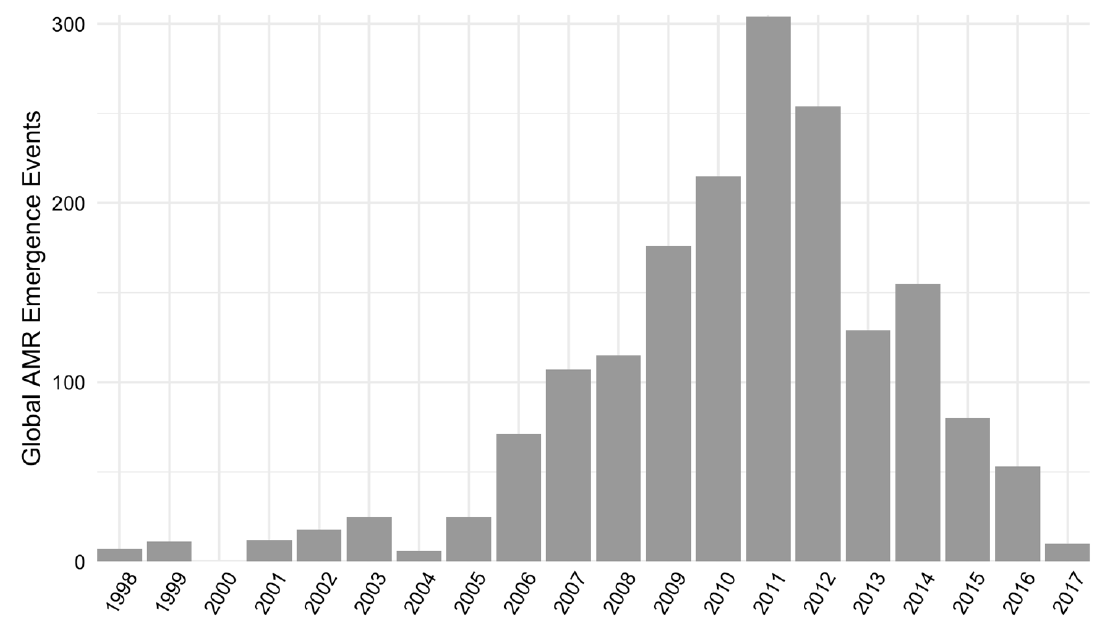
Figure 3. Global number of antimicrobial resistance (AMR) emergence events in the database disaggregated by year.